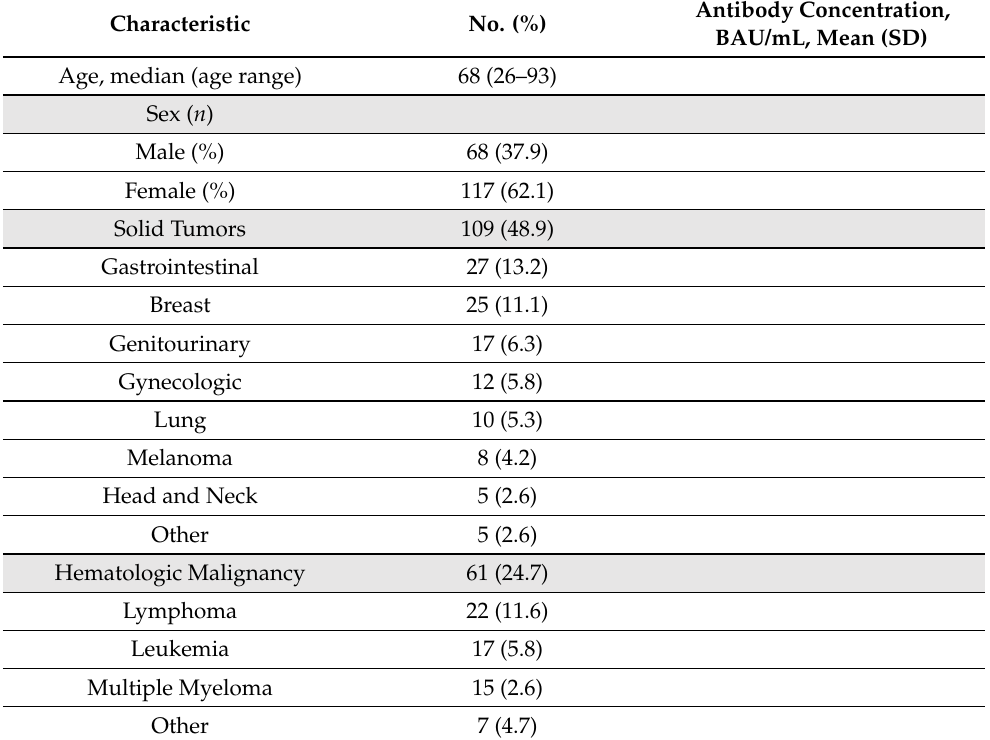
Table 1. Characteristics of the study